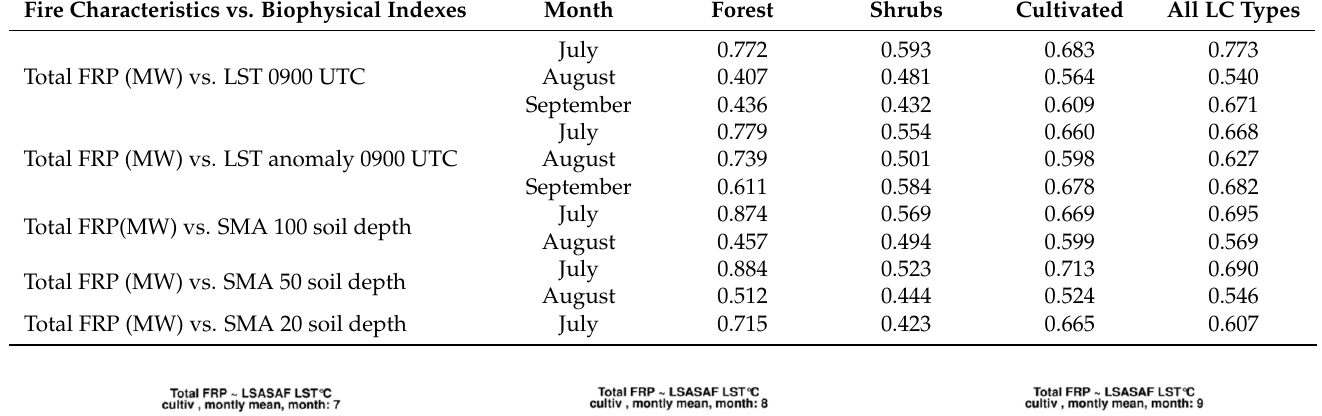
Table 4. Coefficients of determination R 2 of the regression between the energy of biomass burning, FRP (MW), and the monthly mean values of biophysical indexes (July–August, 2007–2018). Only days with fire detections are considered.